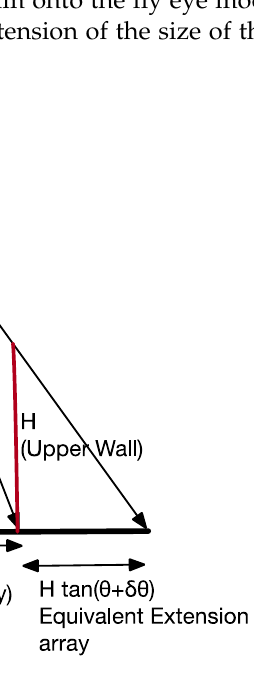
Figure 17. Equivalent extension of the fly eye module size.